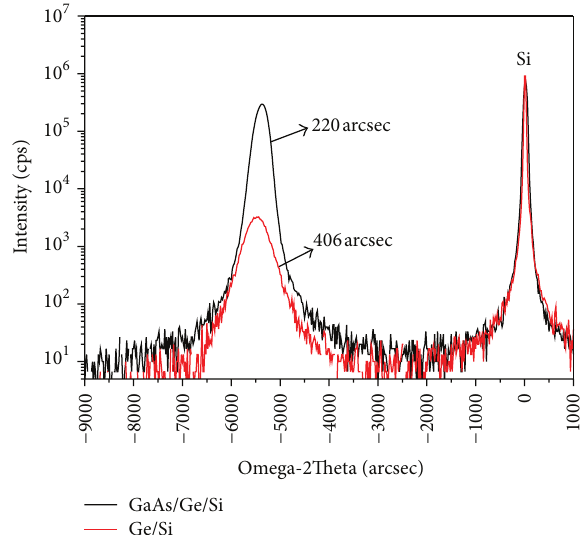
Figure 5: High resolution XRD rocking curve of the Ge and GaAs peak.